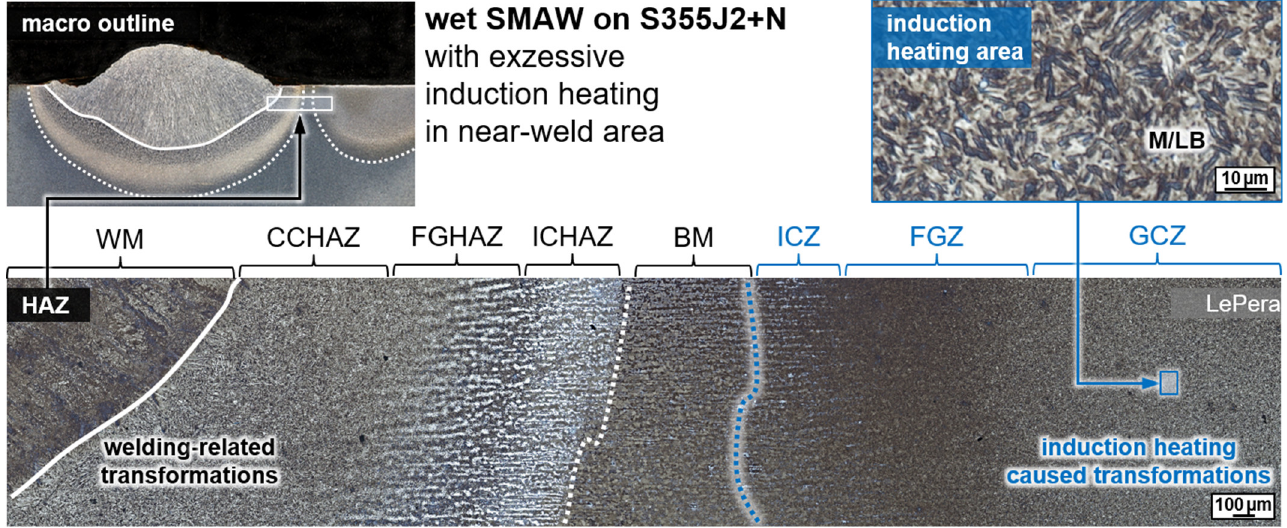
Figure 10. Microstructure in the HAZ of wet SMAW on S355J2+N demonstrating unintended transformation in the near-weld area; see main text for details.